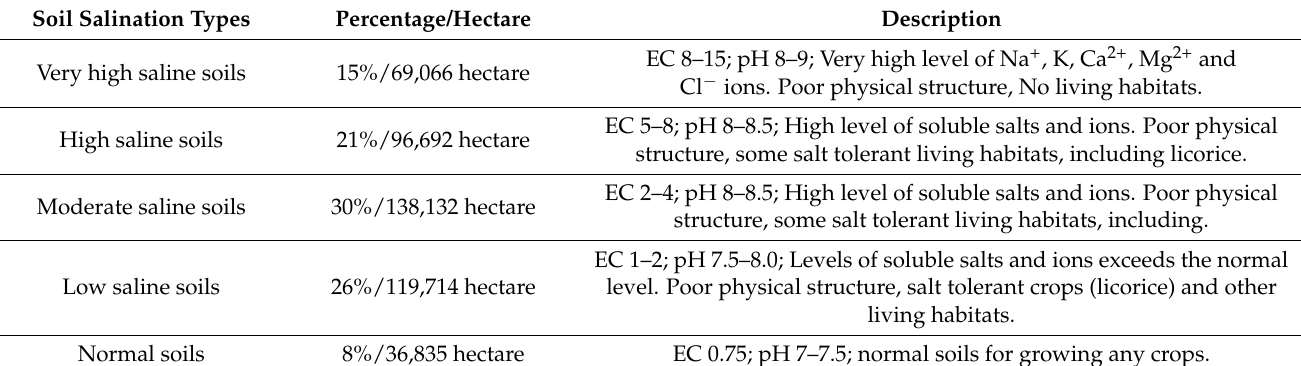
Table 1. Soil salination types in irrigated lands of